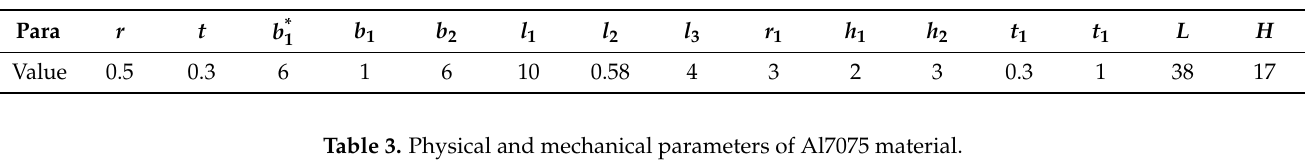
Table 2. Dimensional parameters of stage, unit: mm.